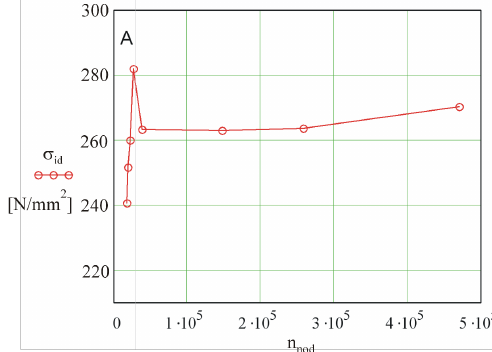
Figure 17: Convergence curve to check the stress σ id in the fillet illustrated in Figure